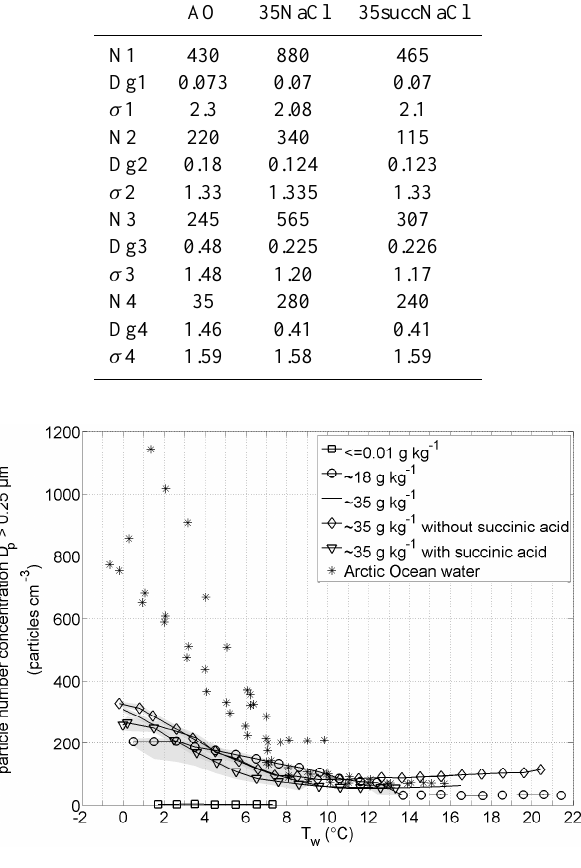
Fig. 3. Median particle number concentrations ( D p > 0.25µm) for waters with different salinities and organic content as a function of water temperature ( T w ). Grey shaded areas indicate the 25th and 75th